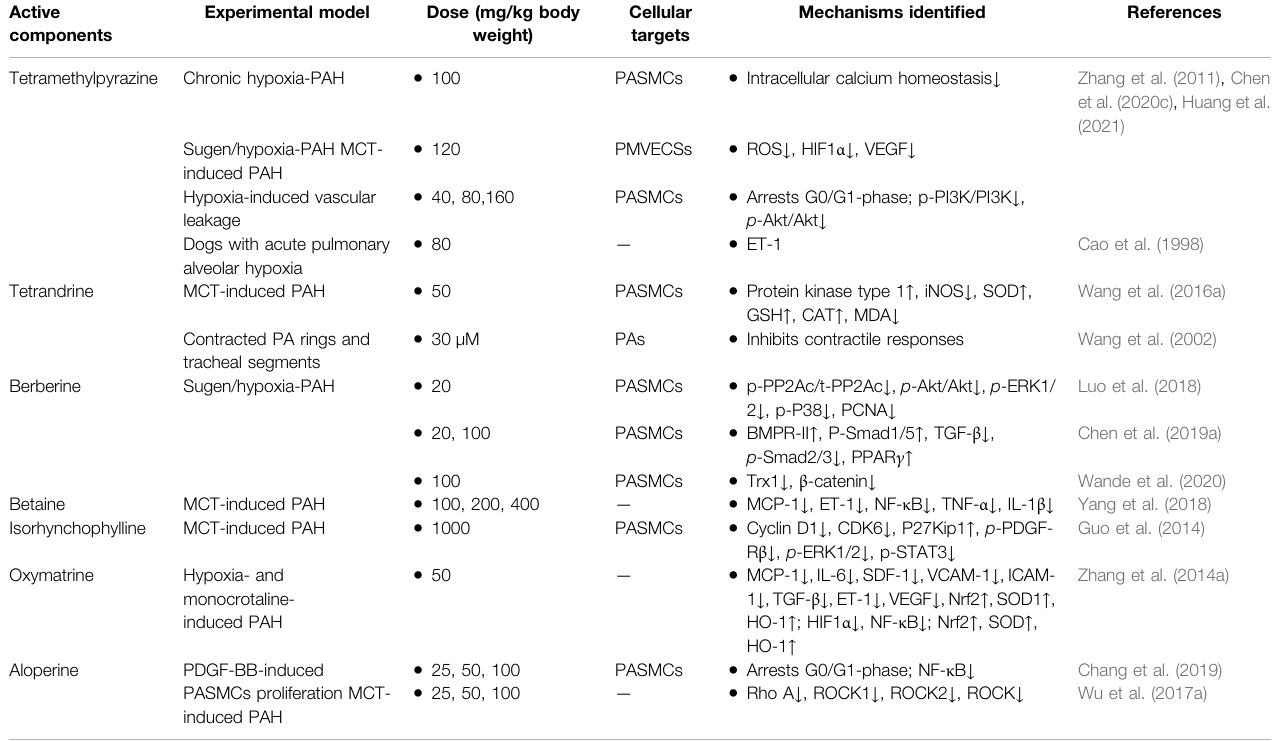
TABLE 4 | Alkaloids as THM-derived active components for PAH treatment. Active